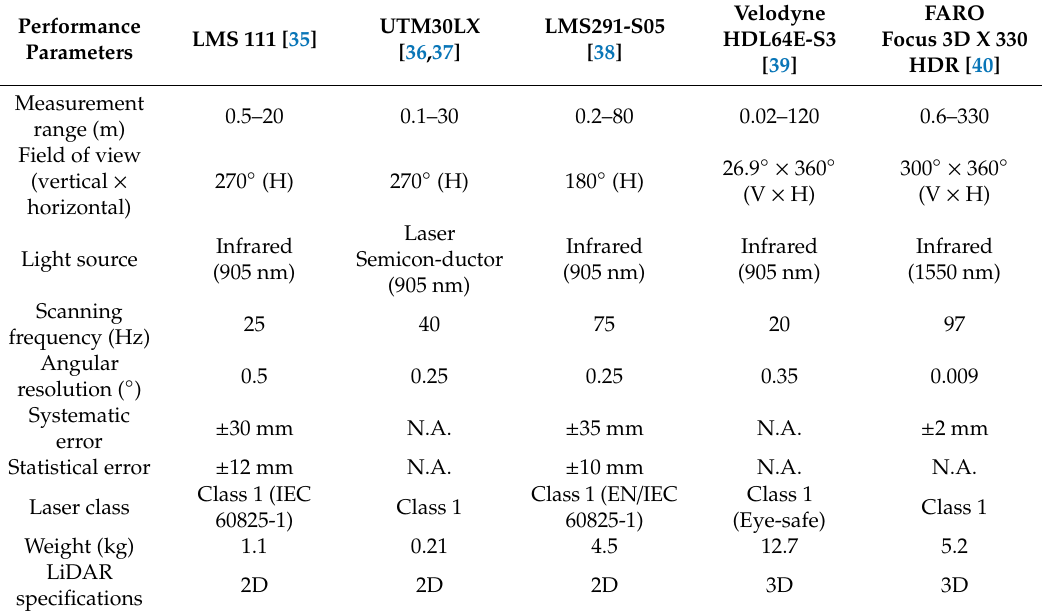
Table 5. Low-cost T-LiDAR (Terrestrial LiDAR) scanners